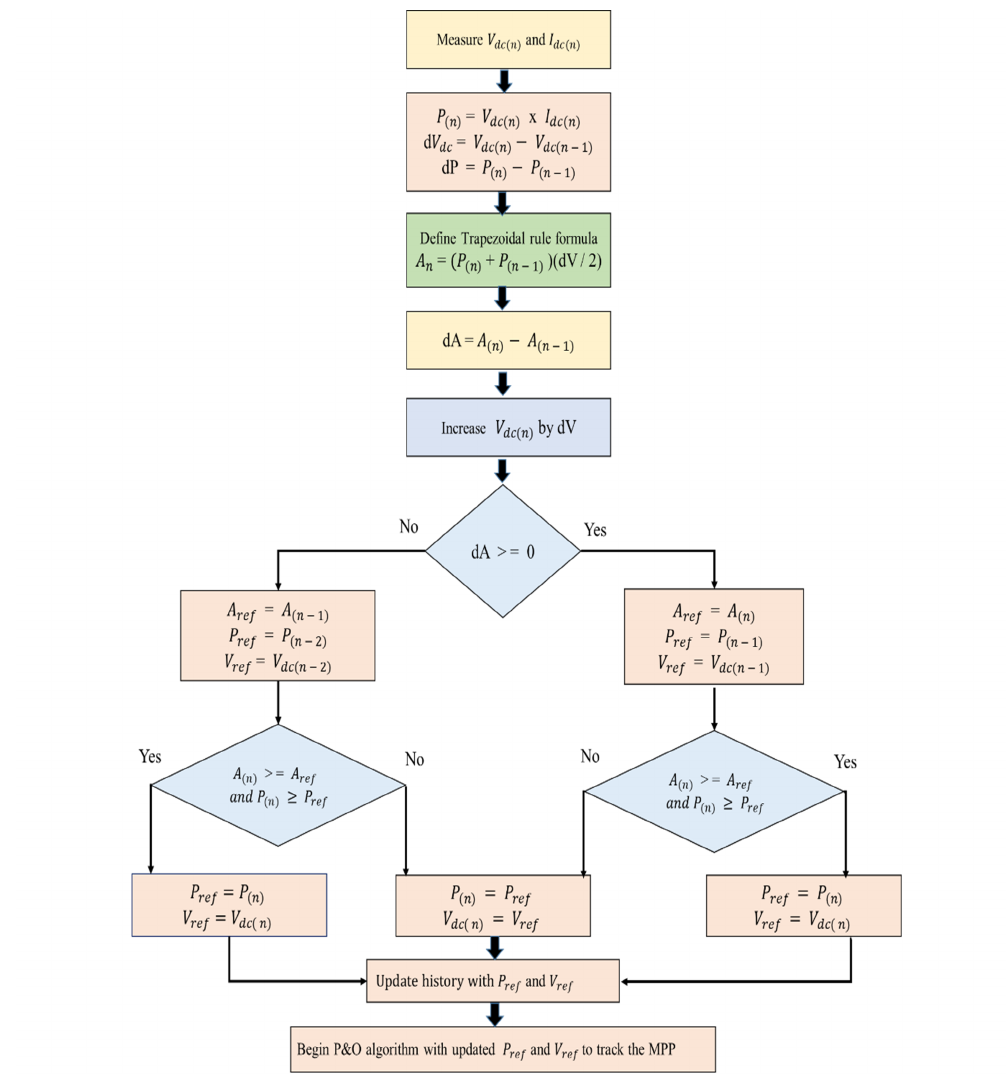
Figure 10. Flowchart of the proposed MPPT